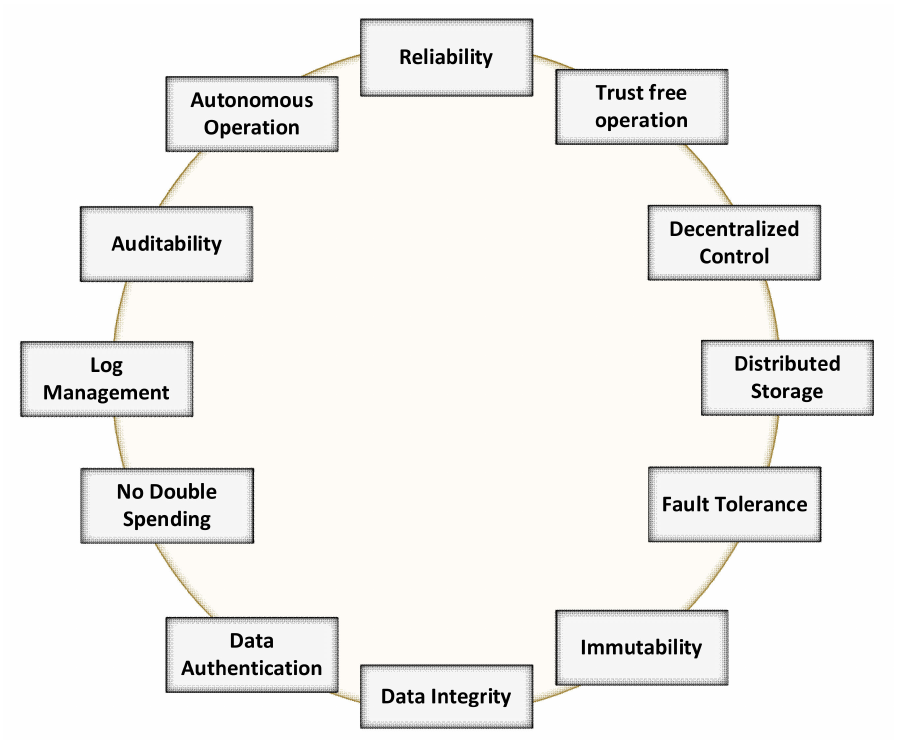
Figure 6. Integrated healthcare applications of BC and